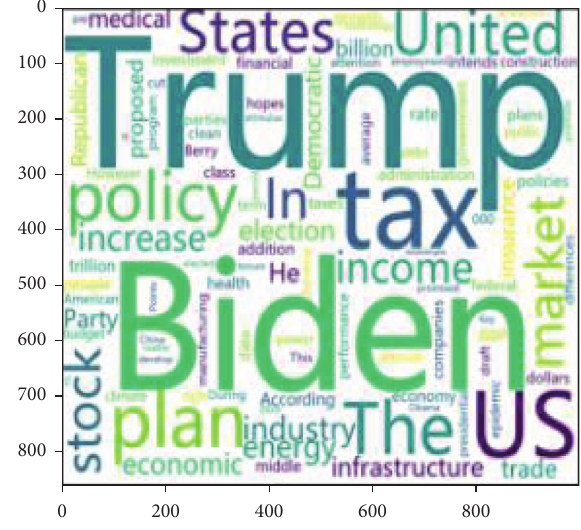
Figure 12: The US election word